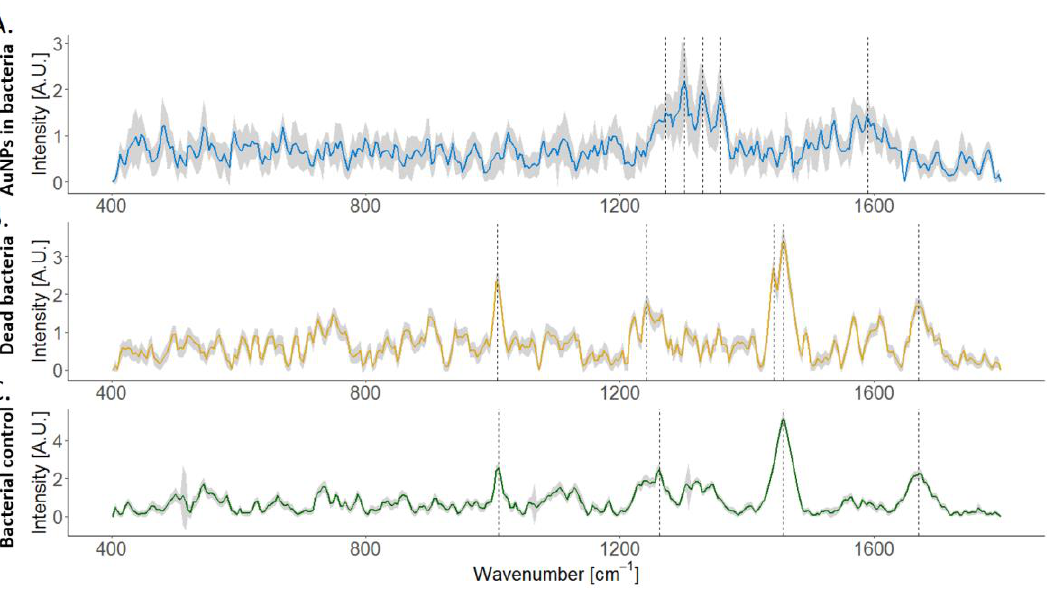
Figure 3. Raman spectra based on R5 conditions (0.2 mM of initial gold concentration, anoxic conditions, pH 5, and in the presence of H 2 as an electron donor), ( A ) initially viable S. oneidensis that produced AuNPs (number of cells considered n = 128); ( B ) heat-killed S. oneidensis that produced fewer AuNPs (n = 44) ( C ); S. oneidensis without exposure to the metal as control (n = 114). The standard deviation is shown in